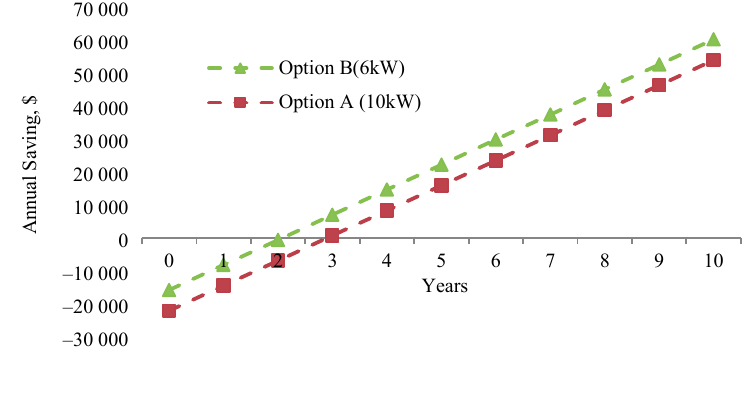
Fig. 3. Total saving for the two options over their